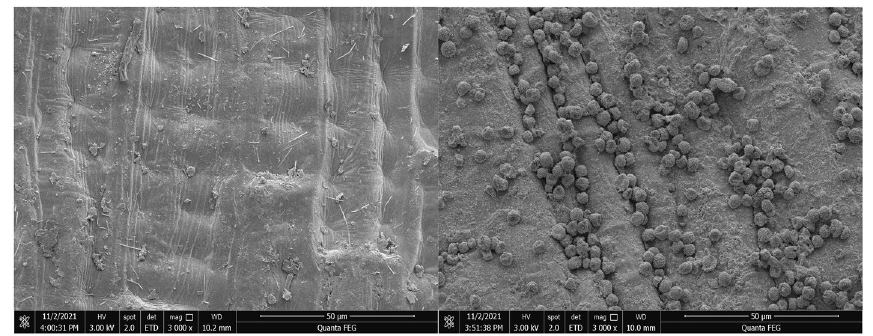
Figure 1. Comparison images between the healthy and the moldy wheat carrying 50% AFB1 under the electron